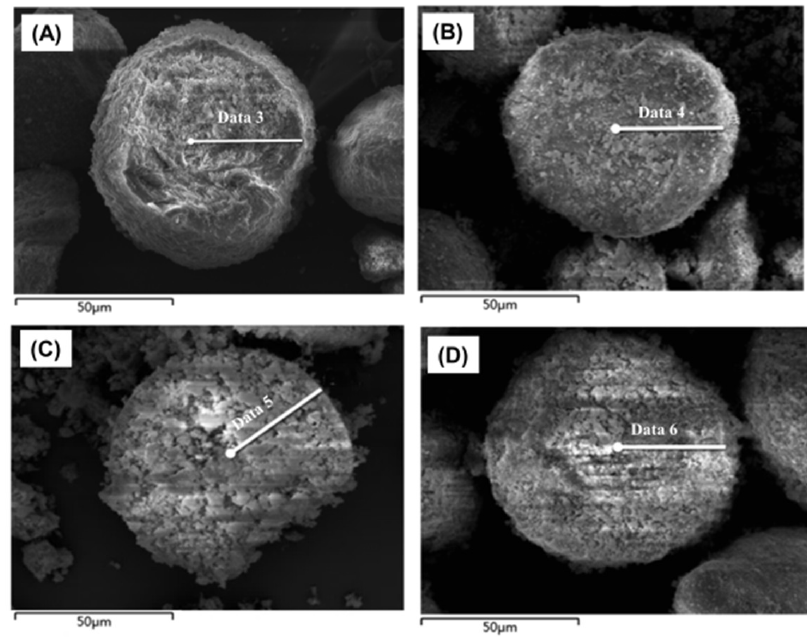
Figure 3. Line scan across a particle: ( A ) E-cat, ( B ) CAT-MM1, ( C ) CAT-MM2, and ( D ) CAT-CD.